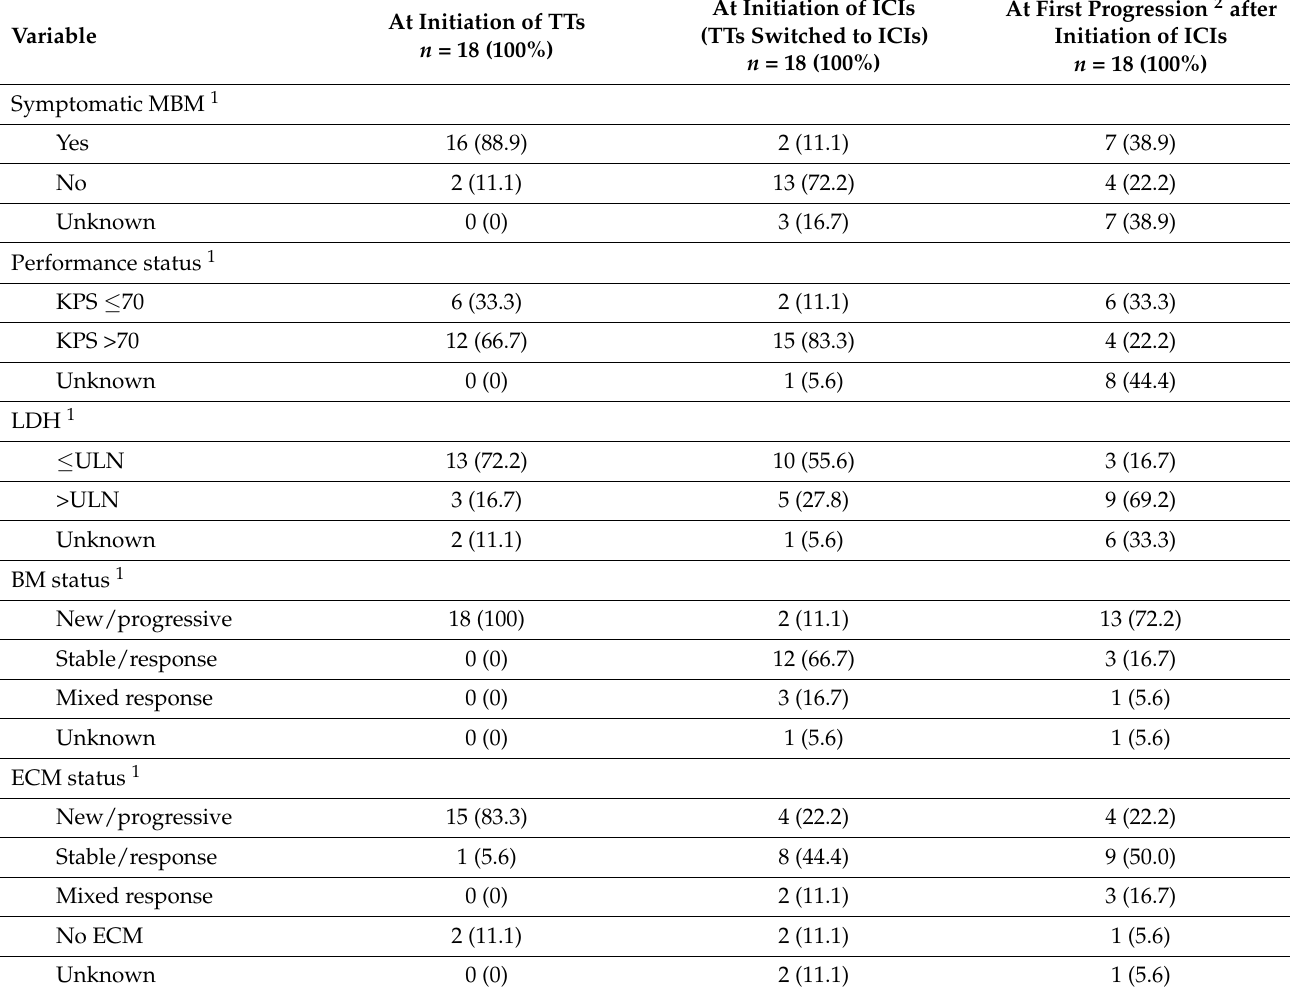
Table A7. A subgroup of 18 patients with melanoma brain metastasis (MBM) who switched from initial targeted therapies (TTs) to immune checkpoint inhibitors (ICIs) after MBM